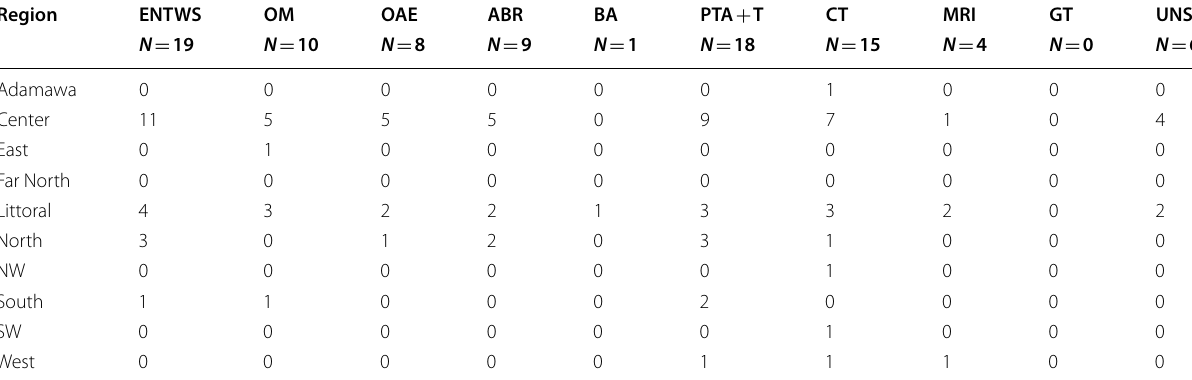
Table 2 Distribution of facilities with diagnostic equipment for hearing loss by administrative